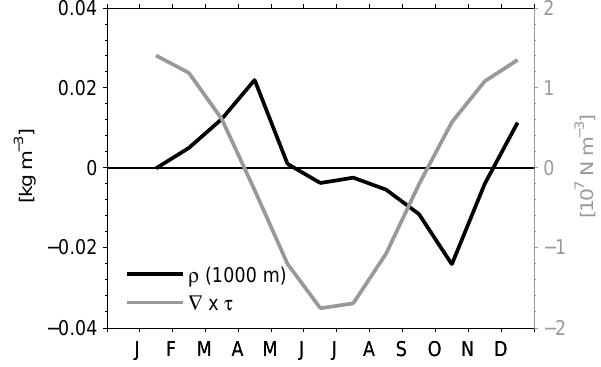
Fig. 16. Monthly means of in-situ density anomaly at 1000m from EBH (black), and seasonal cycle of wind stress curl ( ∇ × τ) anomaly at 27 ◦ 7.5 0 N, 15 ◦ 22.5 0 W (about 200km away from the position of the shallowest mooring at EBH), based on the SCOW climatology (Risien and Chelton, 2008;